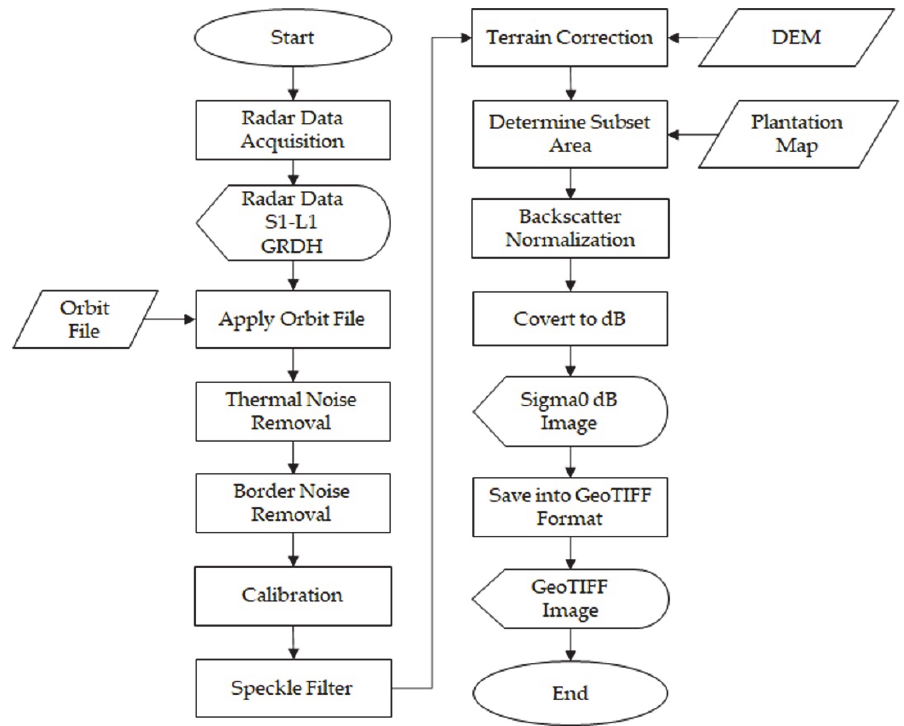
Figure 3. The imagery data processing steps (flowchart) using Sentinel ‐ 1.